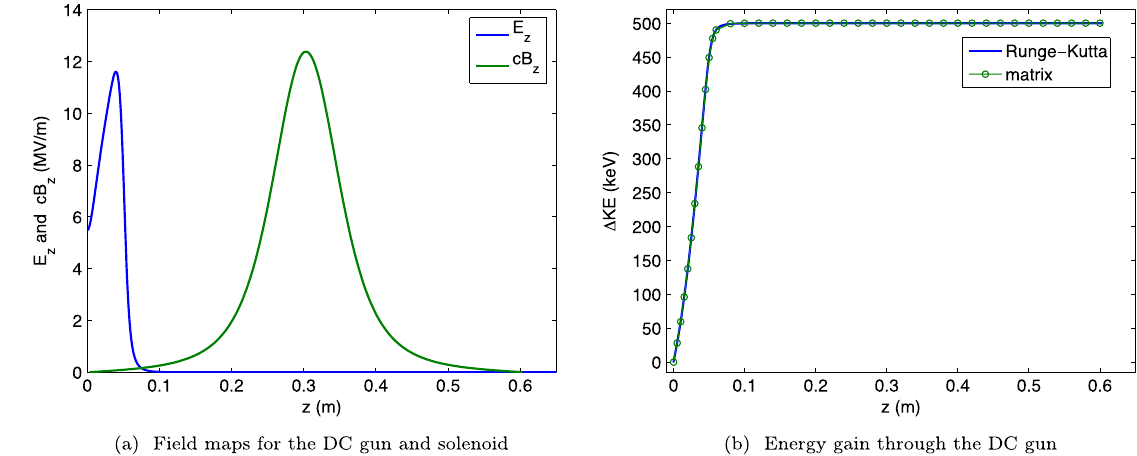
FIG. 1. The fields and energy gain for a 500 kV gun voltage, 0.04 T maximum solenoid field setting, and 1 eV initial kinetic